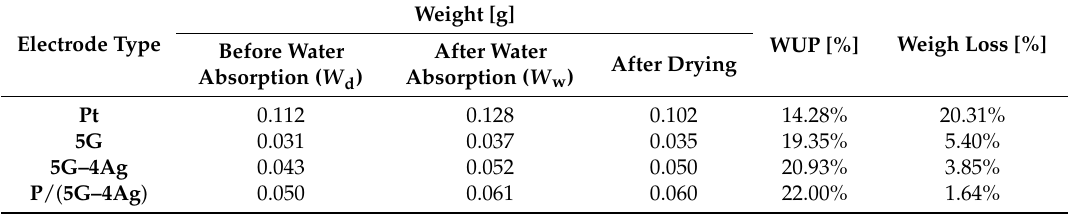
Table 2. Weight change and water uptake potential of Pt, 5G, 5G–4Ag, and P/(5G–4Ag)